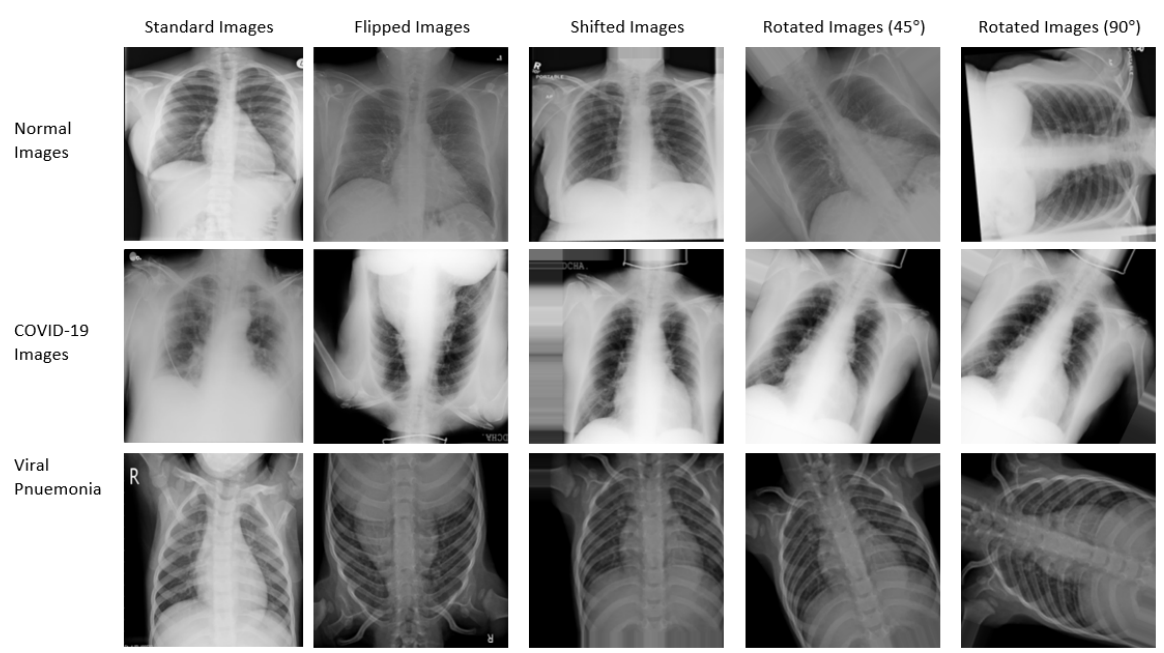
Figure 3. Samples of standard and augmented X-ray images used for training.